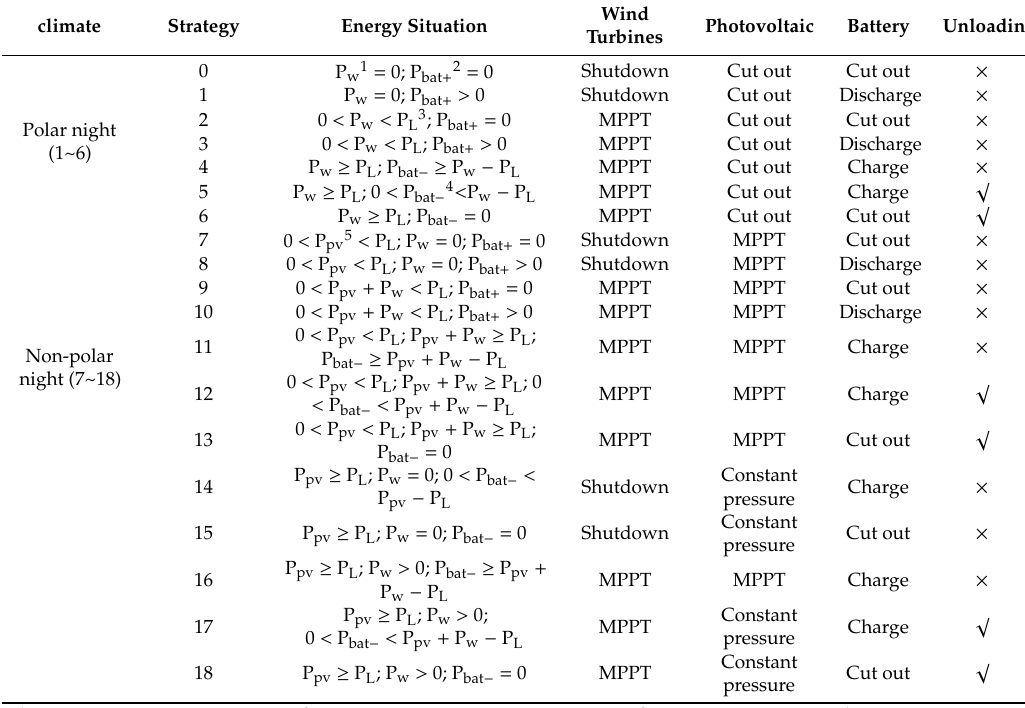
Table 2. Electric Energy Management Strategy of the Power Supply System.